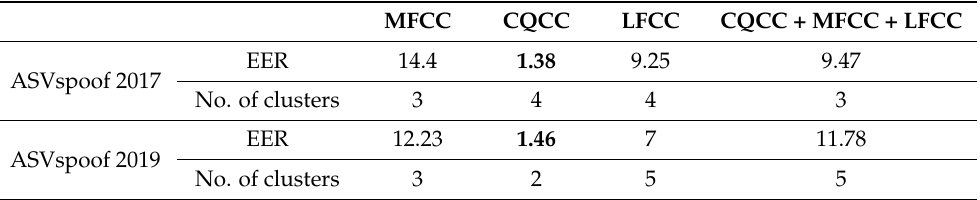
Bold number indicates the lowest EER